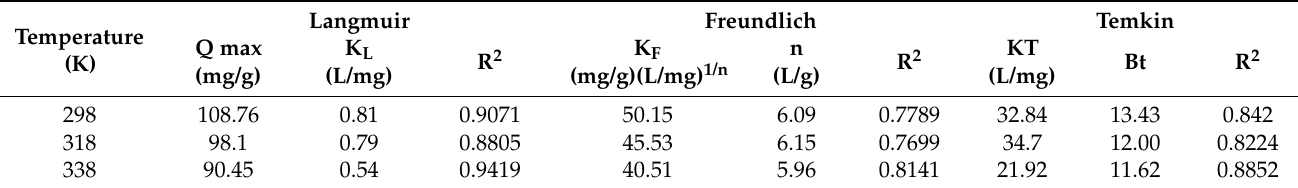
Table 3. Sorption isotherm parameters.